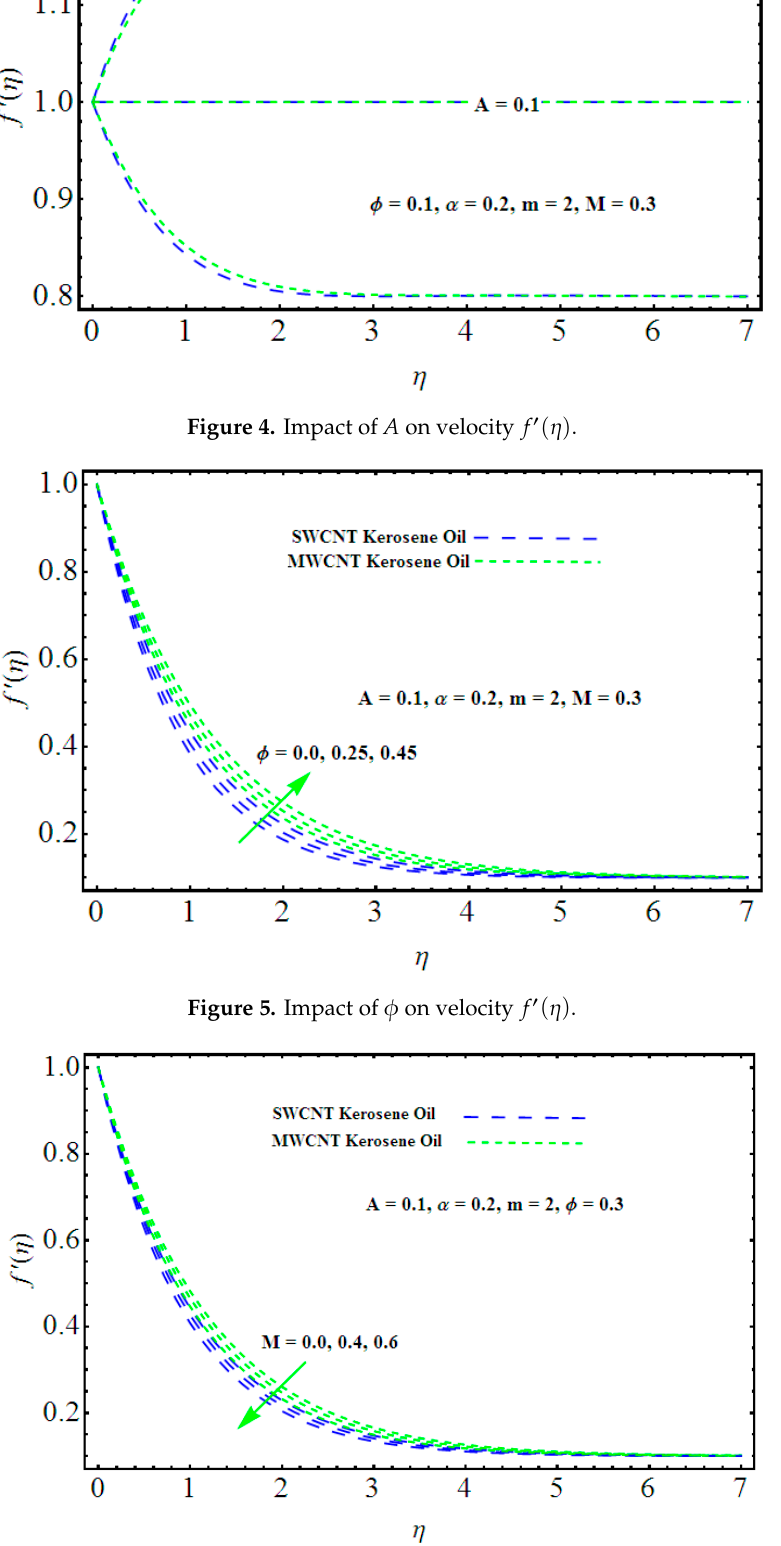
Figure 7. Impact of 𝑚 on velocity 𝑓 (cid:4593) (𝜂) .